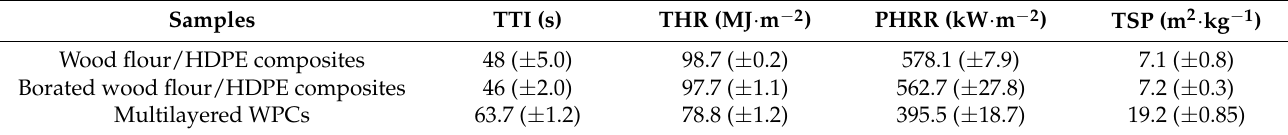
Figure 3. Flame–retardant properties of wood flour/HDPE composites with and without boric acid (BA). ( a ) Heat release rate (HRR), ( b ) total heat release THR, ( c ) smoke production rate (SPR), and ( d ) total smoke production (TSP). Table 2. Cone calorimeter test data of the resulting composites with 30% wood flour